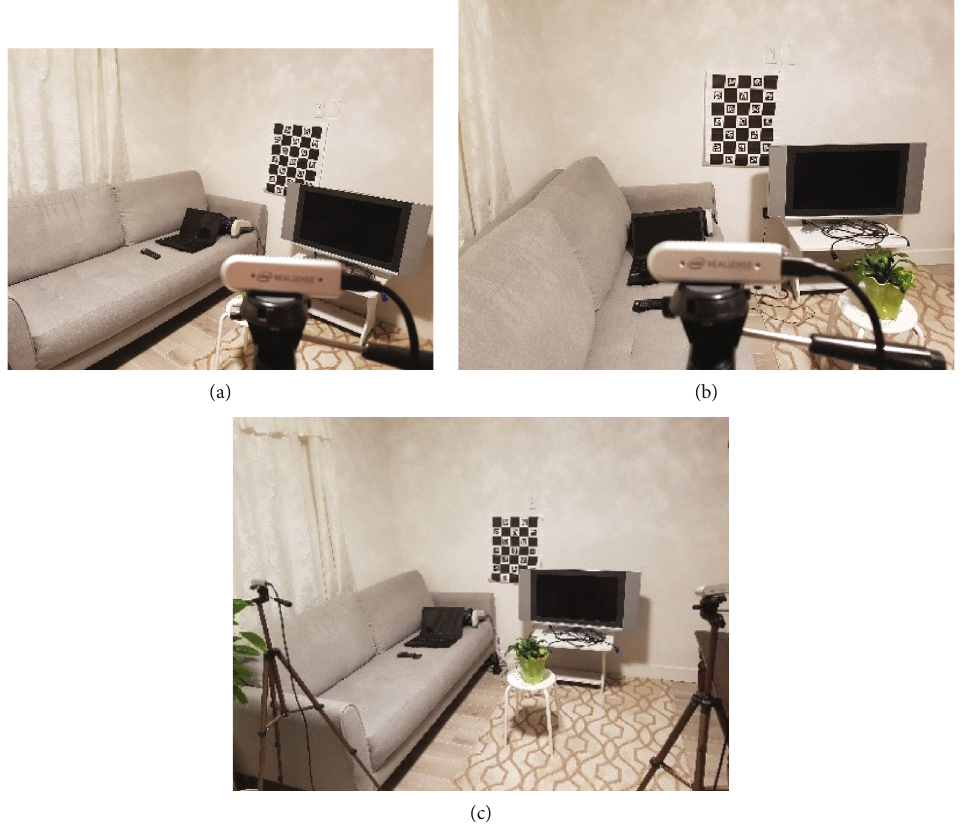
Figure 5: Example of sensor setup for the fi rst case study after the older adult has left the monitoring area. (a, b) show the RGB view from the left and right sensors. (c) shows the full view of the monitoring area including the locations of the left and right